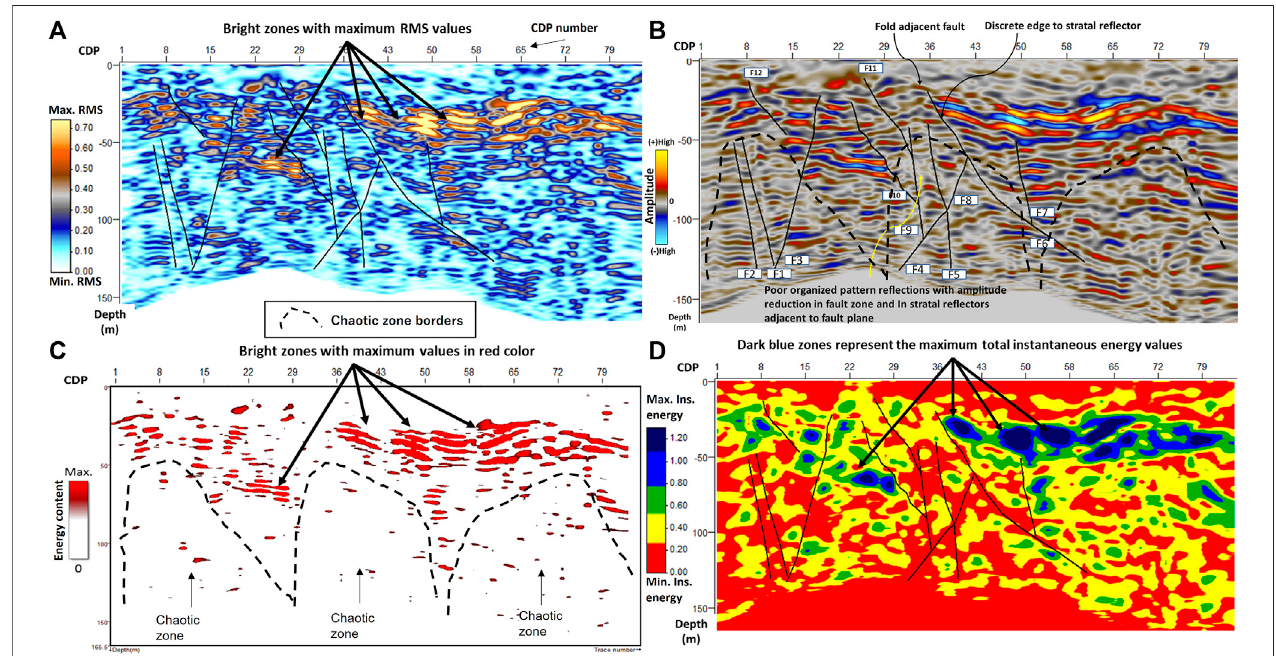
FIGURE7| Seismicattributesperformedatpro fi leA:insection (A) theRMSvaluesperformedareshownandthebrightzoneisindicatedbyarrowswhiletheblack linefollowsfractures;insection (B) thetimegainsectionisshownwiththefracturenamedfromF1toF11;inthesection, (C) thebrightzonesareevidencedusingenergy attributes; fi nally, in the (D) section the energy attributes show and con fi rm the fractures enhancing the total instantaneous energy values.